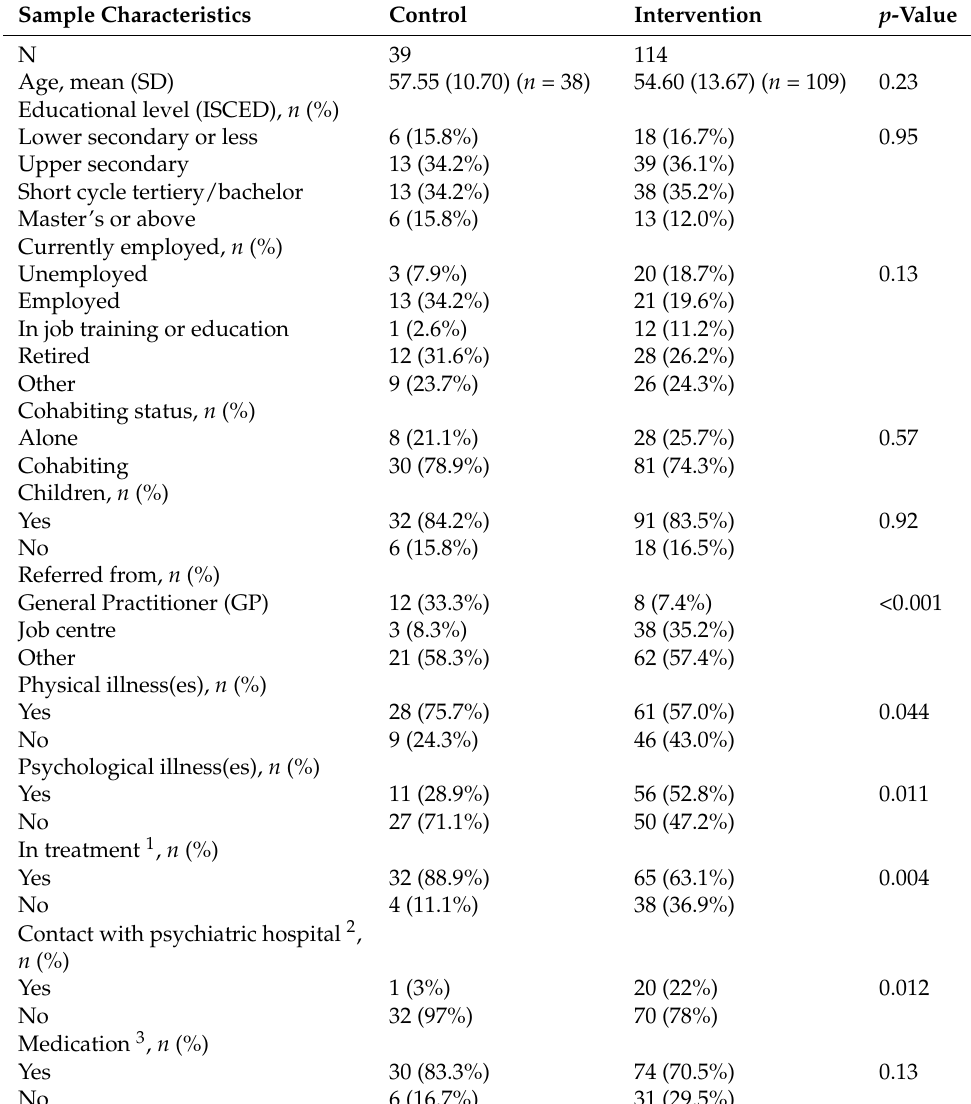
Table 1. Sample characteristics at baseline (N =